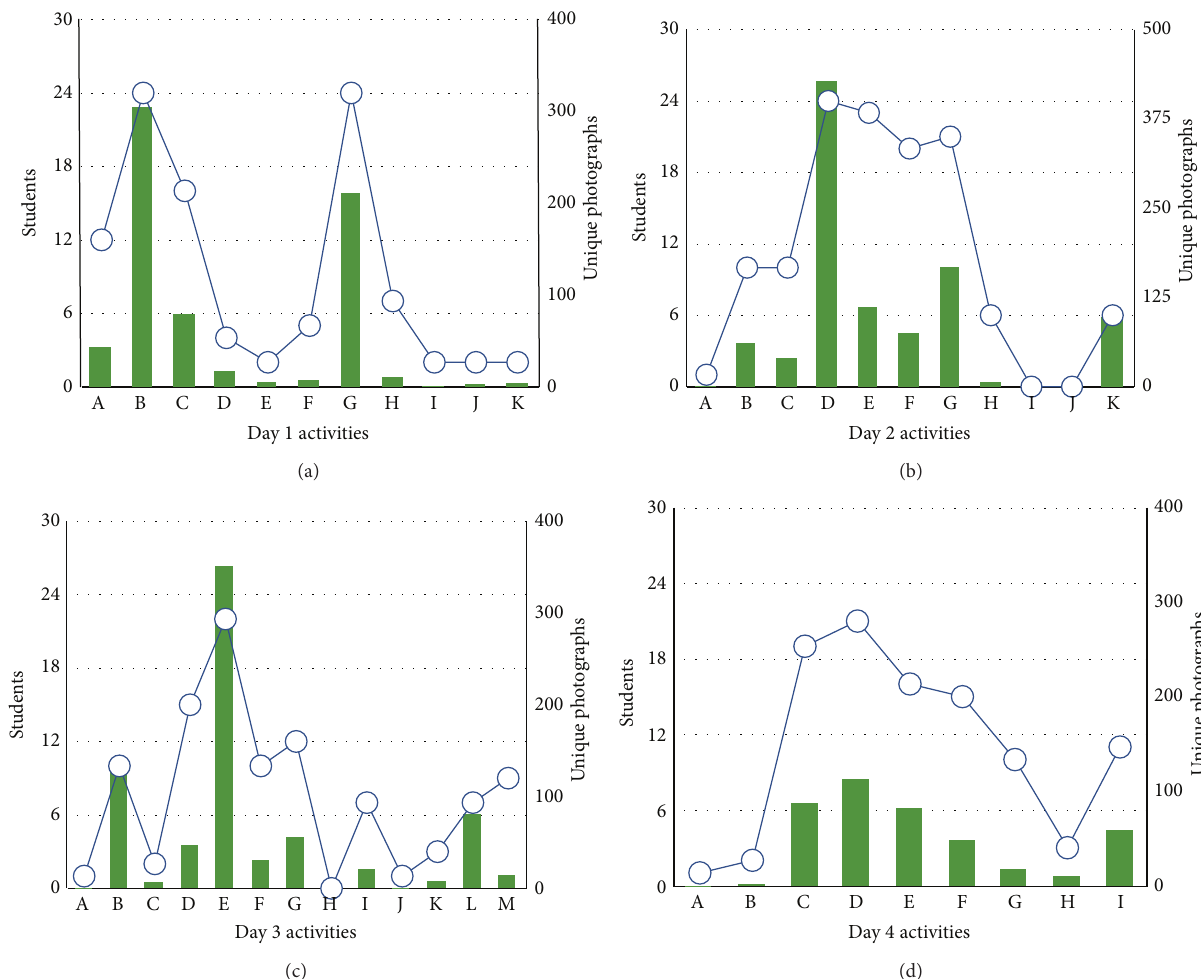
Figure 1: Number of students who had taken photographs of an event (line graph) and number of unique photographs taken during an event (bar) for each day of the field trip. Please note that alphabetic coding of activities is derived from Table